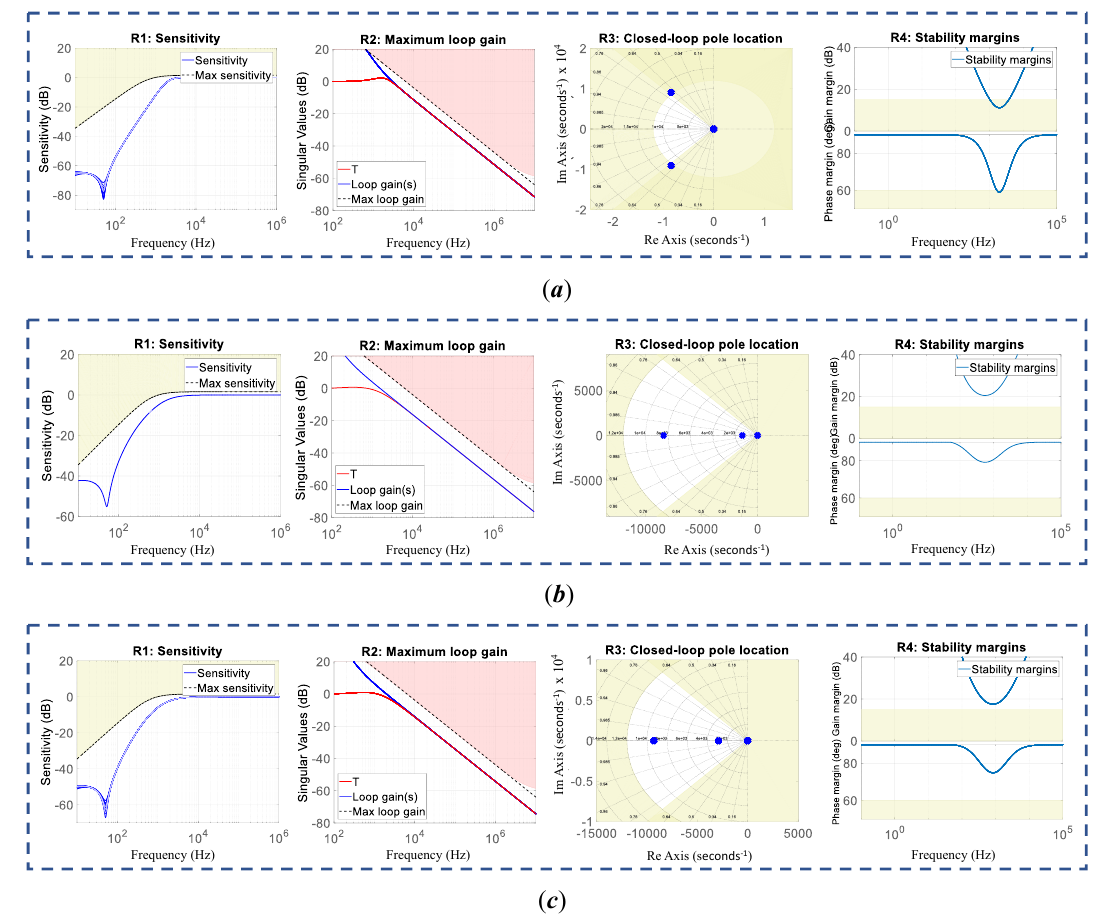
Figure 7. Closed-loop specifications’ verification for the i d and ( c ) H ∞